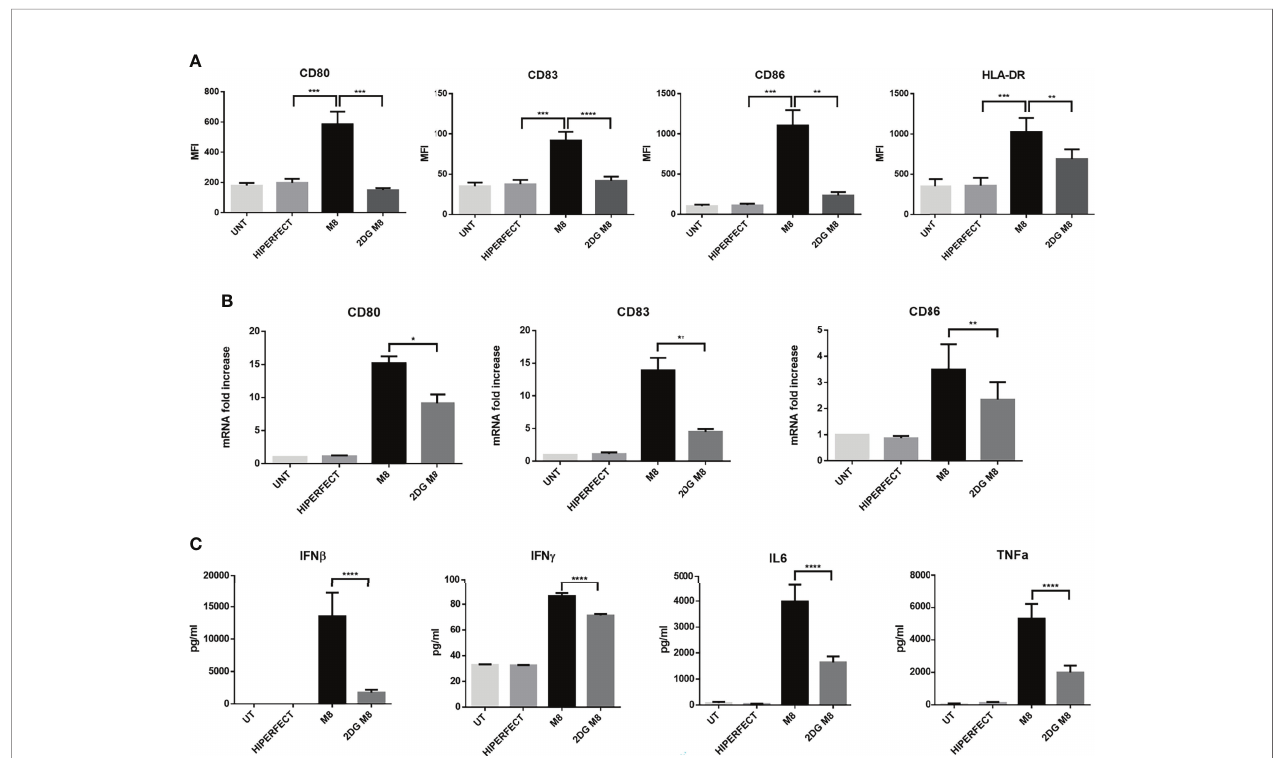
FIGURE 3 | M8-induced upregulation of costimulatory molecules on monocyte-derived dendriticcells (MoDCs) requires glycolysis. (A) MoDCs were either treated or left untreated with 6 mM 2-deoxyglucose(2-DG) 1h prior exposition to 50 ng/ml of M8, and expression of MHC II, CD80, CD83, and CD86 on MoDCs were analyzed by fl ow cytometry after 18h.Histogramsshow the mean fl uorescence intensity of the expression ofthe indicated molecule. Dataare representative of sixindependent experiments. (B) MoDCs were treated as in (A) , RNA was isolated 24h after M8treatment, and the expression ofthe indicated costimulatorymRNAs measured byRT-PCR. (C) Analysis byMagneticLuminex assay ofthe concentration (pg/ml)of proin fl ammatory cytokines IL-6, TNF- a , IFN- g , and IFN- b in supernatants of MoDCs stimulatedfor 24h with M8 (50 ng/ml) with or without 2-DG(6mM) pretreatment. Statistical signi fi cance was de fi ned as follows: * P < 0.05, ** P <0.01, *** P <0.001, and **** P